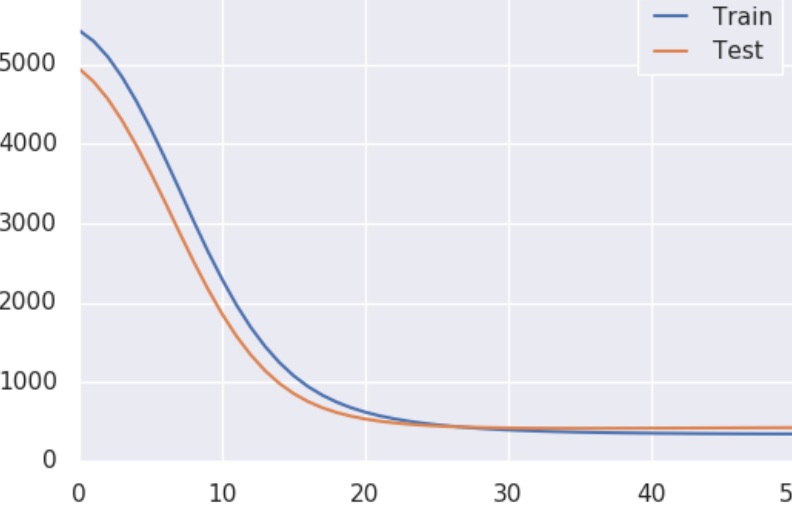
Figure 10. Training and test loss curve of the proposed method.